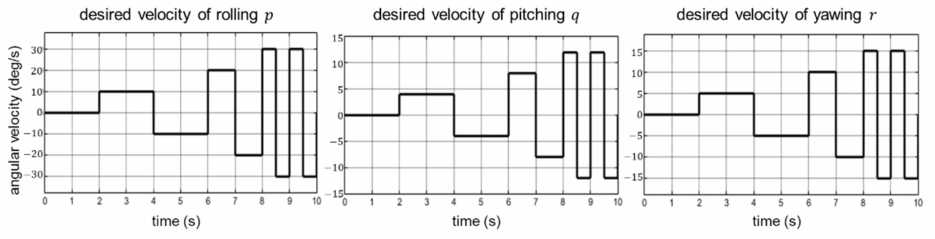
Figure 3. Desired reference angular velocity graphs of roll, pitch, yaw orientation.